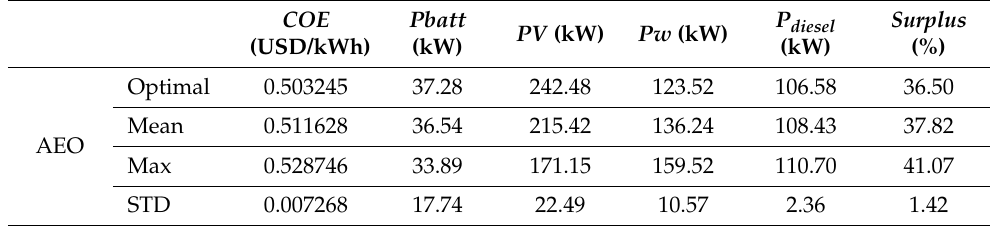
Table 7. Optimal, Minimum, Maximum, and STD for AEO, FSA, and HHO with DSM at 80% REF and 0%